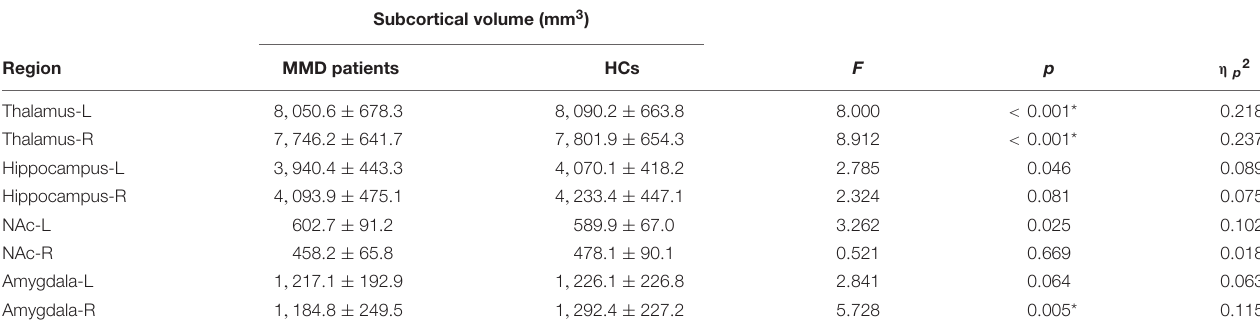
FIGURE 2 | Comparison of HAMD and HAMA scores between the two groups, and correlation between HAMD and HAMA scores in MMD patients. Top panel : HAMD, HAMA and WMS scores were significantly larger in MMD patients than in HCs. Bonferroni corrected ( ∗ p < 0.05; ∗∗∗ p < 0.001). Bottom panel : Both HAMA and WMS scores were not significantly correlated with HAMD score in MMD patients; WMS score was significantly correlated with HAMA score in MMD patients. The error bars indicate standard error. HAMD, Hamilton Depression; HAMA, Hamilton Anxiety; WMS, Wechsler Memory Scale; MMD, mild-to-moderate depression; HCs, Healthy Controls. TABLE 2 | Differences in subcortical volumes between mild-to-moderate depression (MMD) patients and healthy controls (mean ±